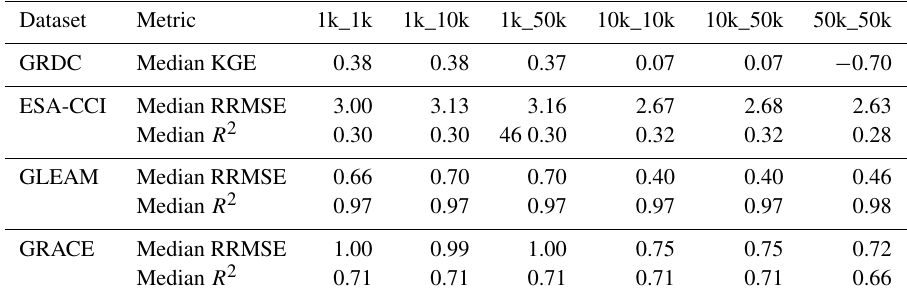
Figure 5. Relative root mean square error (RRMSE) values computed per water province based on simulated upper soil moisture and observations from ESA-CCI. Table 2. Overview of median evaluation metrics per run per evaluated variable except for